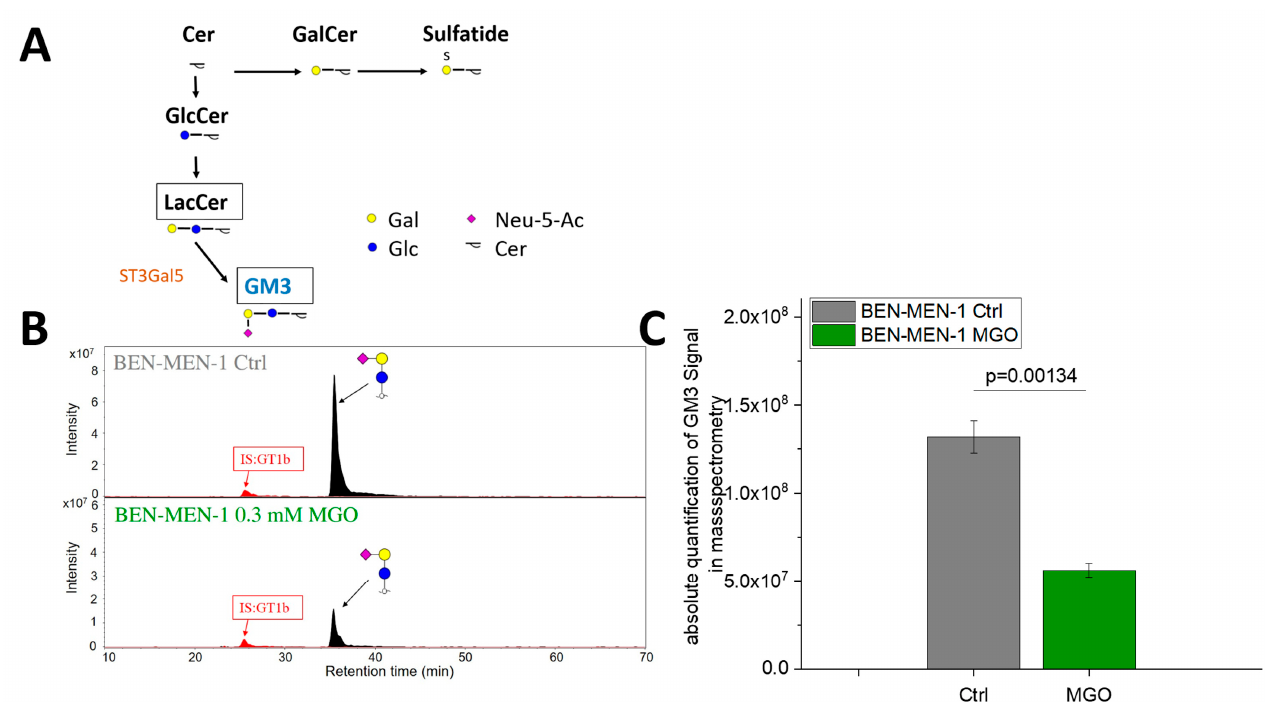
Figure 7. Absolute quantification of GM3 signal by PGC nano-LC-ESI-MS/MS. ( A ): Schematic representation of the GM3 biosynthesis. Cer = Ceramide; GalCer = Galactosylceramide; GlcCer = Glucosylceramide; LacCer = Lactosylceramide; GM3 = Monosialoganglioside 3. ( B ): Signal intensity of GM3 in BEN-MEN-1 Ctrl and BEN-MEN-1 0.3 mM MGO in comparison to the internal standard GT1b. ( C ): Absolute quantification of GM3 signal by PGC nano-LC-ESI-MS/MS of Ctrl (grey) and 0.3 mM MGO-treated BEN-MEN-1 (green). Statistical analysis was performed using t -test and error bars represent SD (n = 3; p = 0.00134).